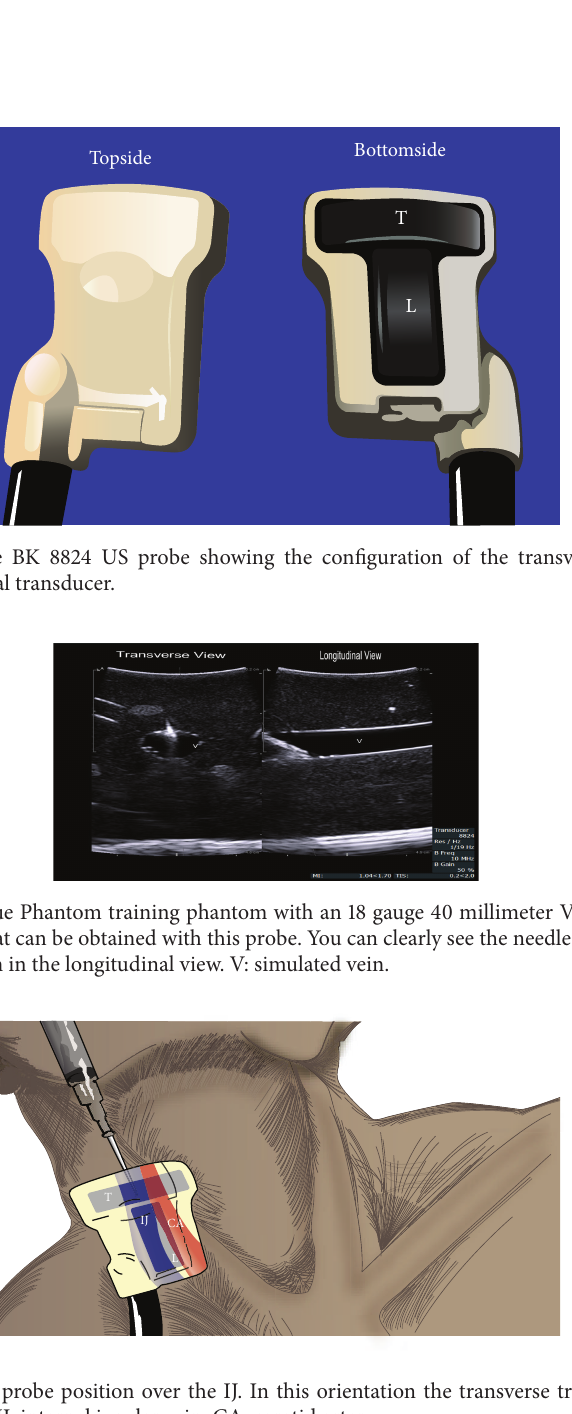
Figure 3: A depiction of the intended probe position over the IJ. In this orientation the transverse transducer is cephalad. T: transverse transducer; L: longitudinal transducer; IJ: internal jugular vein; CA: carotid